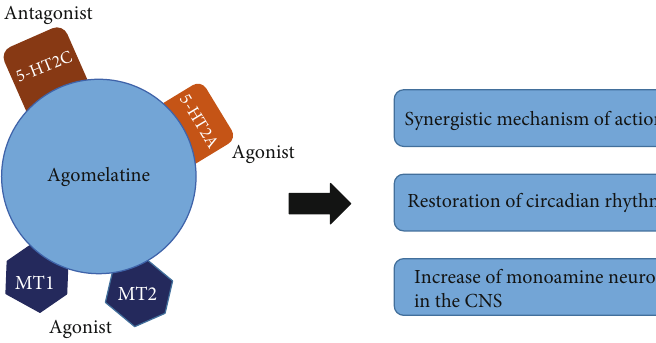
Figure 2: The possible mechanism of agomelatine to improve